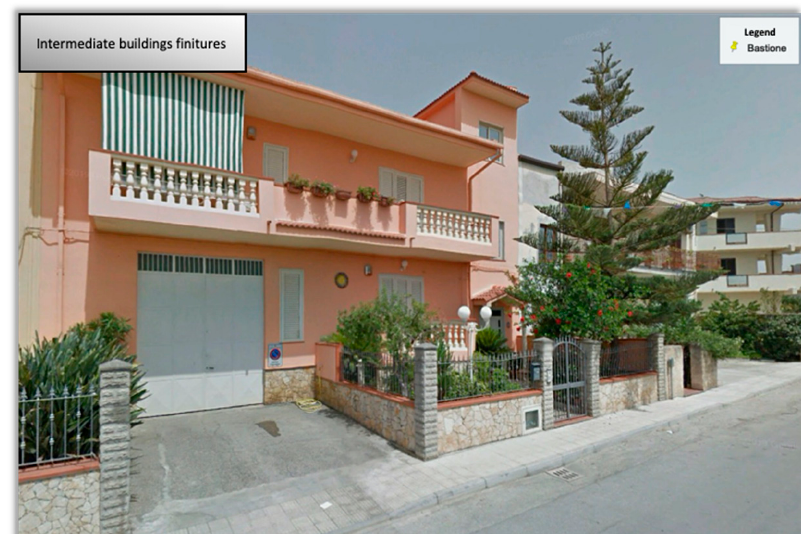
Figure 7. Example building with intermediate finishes.